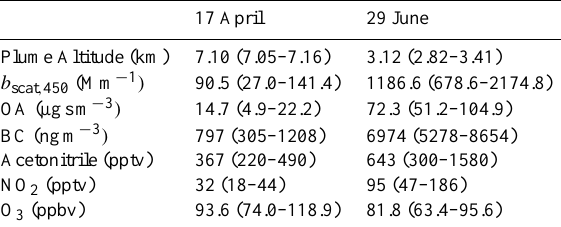
Table 1. In-plume mean altitude, b scat , 450 and concentrations of OA, BC, acetonitrile, NO 2 , and O 3 . In-plume ranges are shown in parentheses.